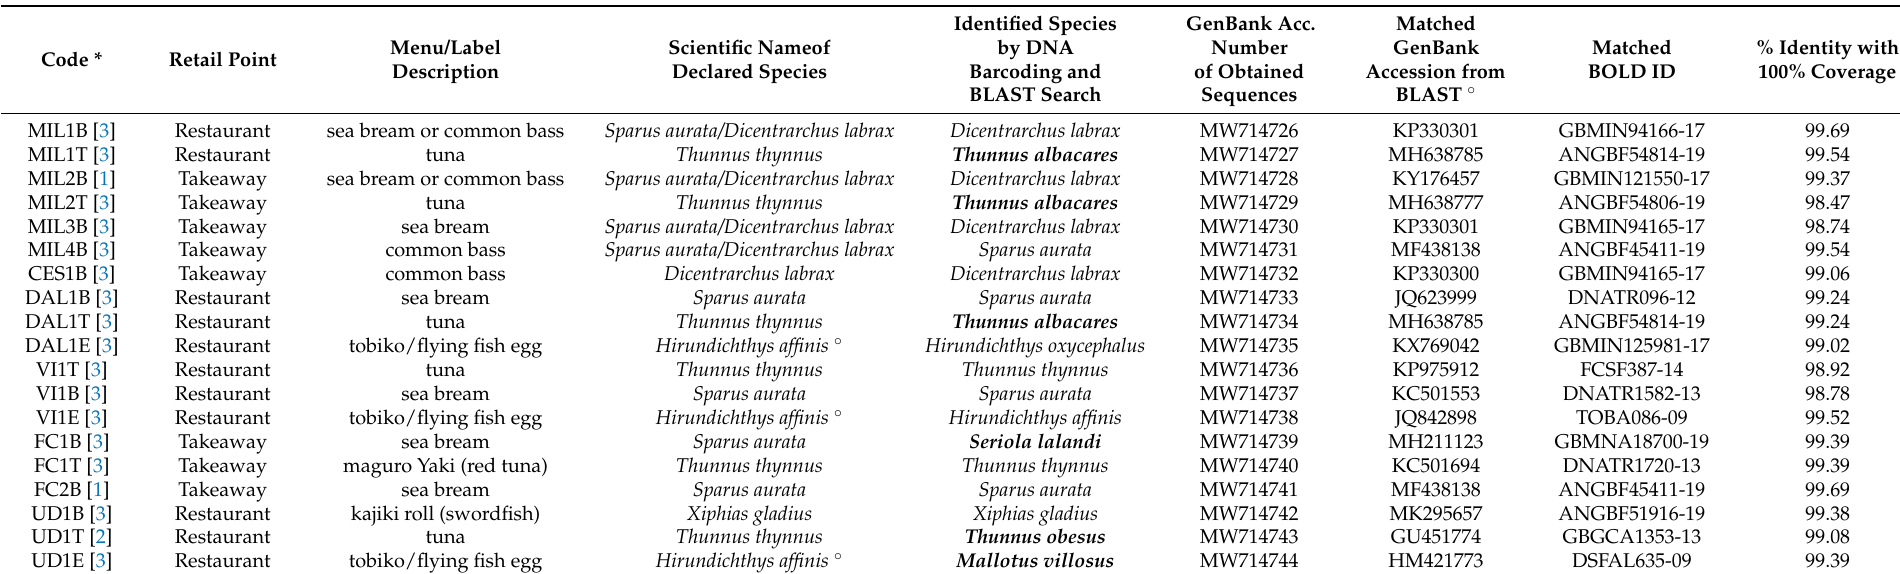
Table 1. Sushi sampling in Northern Italy. In square brackets, the number of processed samples for each sushi product. In bold, misdescription cases.